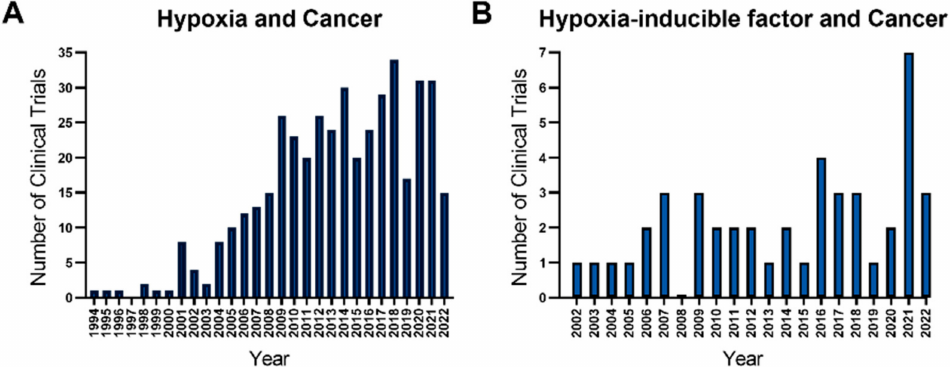
Figure 1. The number of clinical studies in cancer registered on https://clinicaltrials.gov that mention the impact of hypoxia ( A ), and hypoxia-inducible factor ( B ). We searched https://clinicaltrials.gov/ ct2/home (accessed on 24 May 2022) to find all the clinical trials registered till 24 May 2022 that mention the terms “hypoxia” or “hypoxia-inducible factor”. The number of studies started each year was counted from the compiled list to draw the graphs in the figure with GraphPad Prism 9. The counts for 2022 only represent the studies started between 1 January 2022 and 24 May